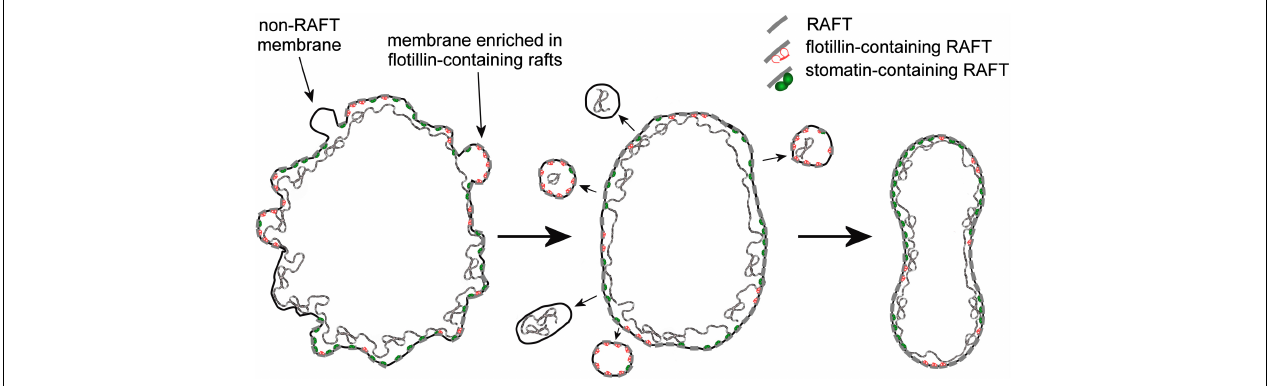
FIGURE 6 | Graphical conceptualization of the process of membrane raft enrichment in the maturation of R2 Retics. From a large and irregularly shaped R2 Retic (left) selected portions of non-raft membrane, or membrane selectively enriched in flotillin-2-containing rafts, together with some membrane skeleton are lost or, more likely, pinched off in the splenic milieu by the action of macrophages. The now resized lipid bilayer (middle) completes the anchoring to the membrane skeleton also thanks to the contribution of membrane raft interaction with the spectrin network, resulting in a mature and stable discocytic shape (right). The anchoring complexes based on band 3-ankyrin and the actin-based junctional complexes have been omitted for clarity. Membrane rafts are shown as short segments crossing the lipid bilayer. The various components are not drawn in scale.